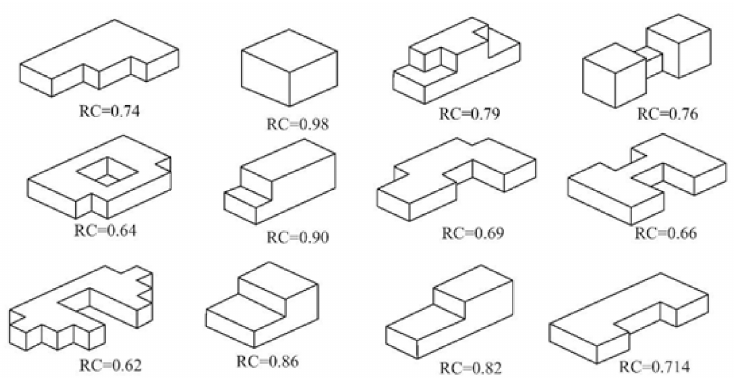
Figure 2. Building shapes with respect to the relative compactness (RC) values.